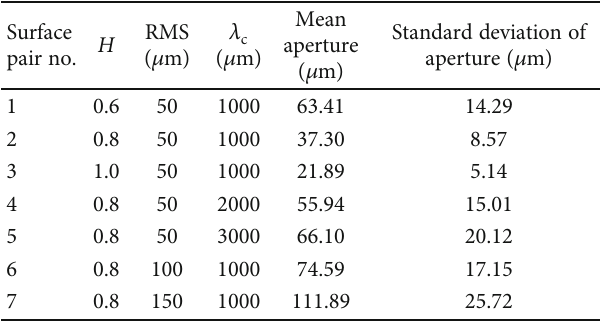
Table 3: Mean and standard deviation of the aperture fi eld for the seven surface pairs.